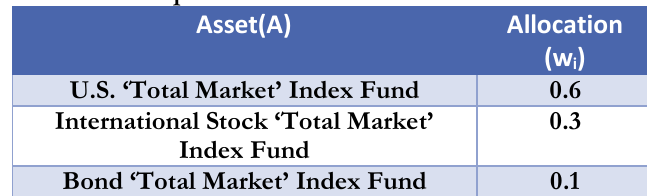
Table 1: Example 3-Fund